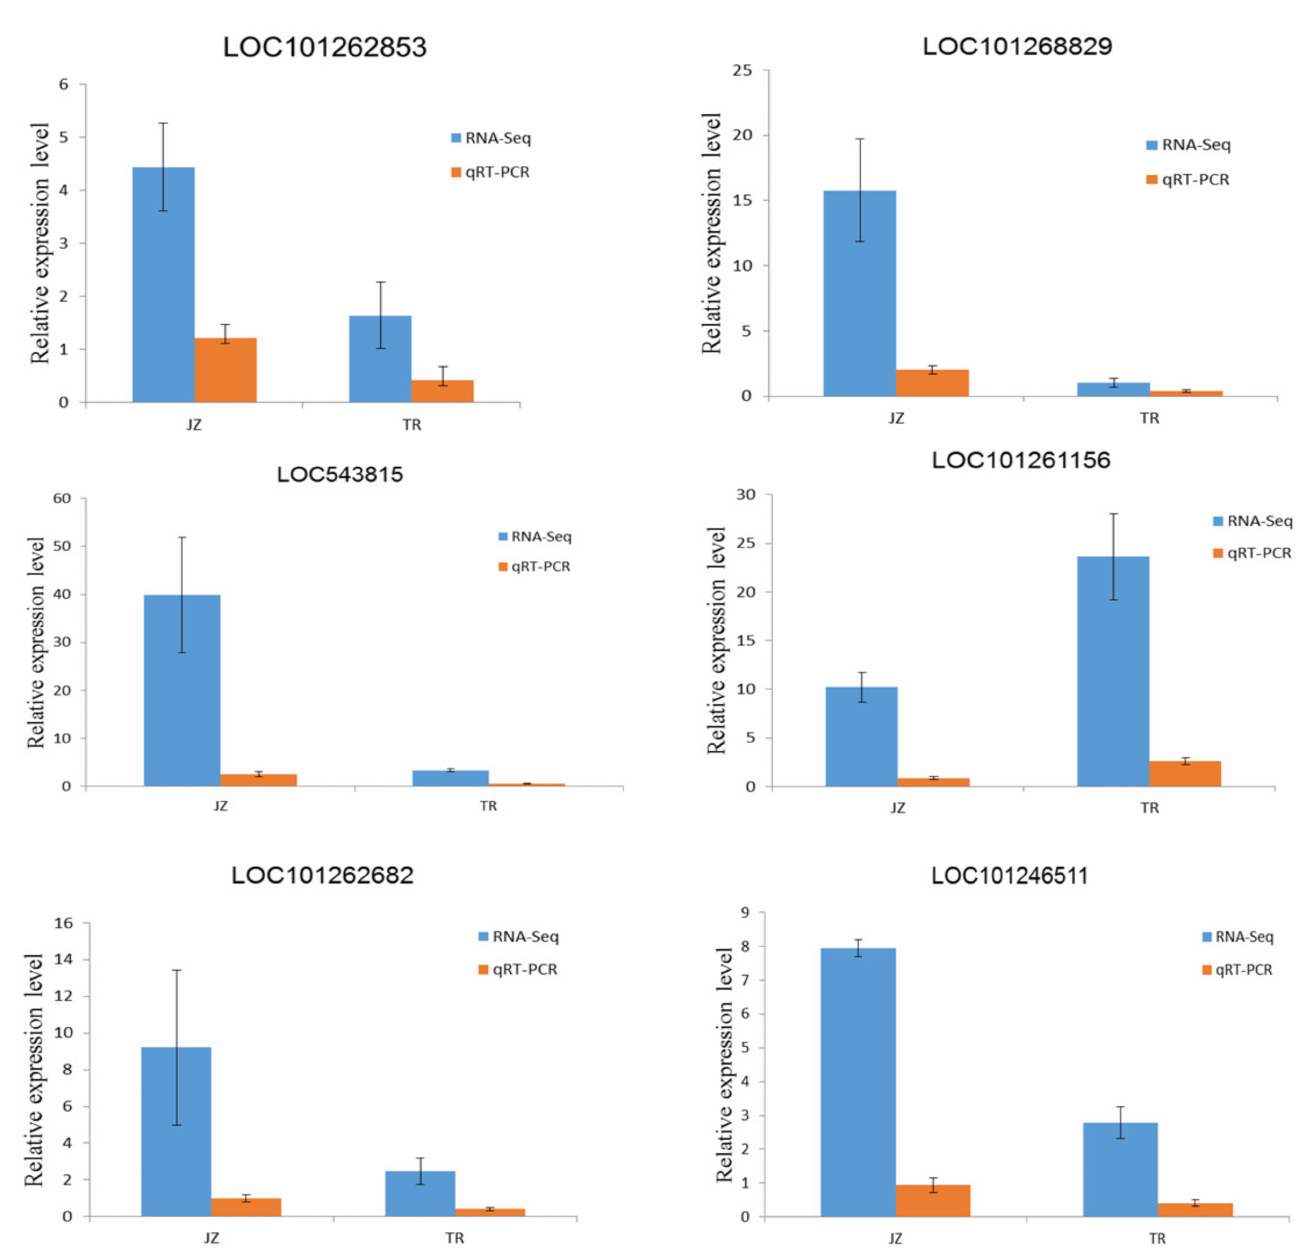
Figure 6. qRT-PCR verification results. JZ = Soilless substrate. TR =